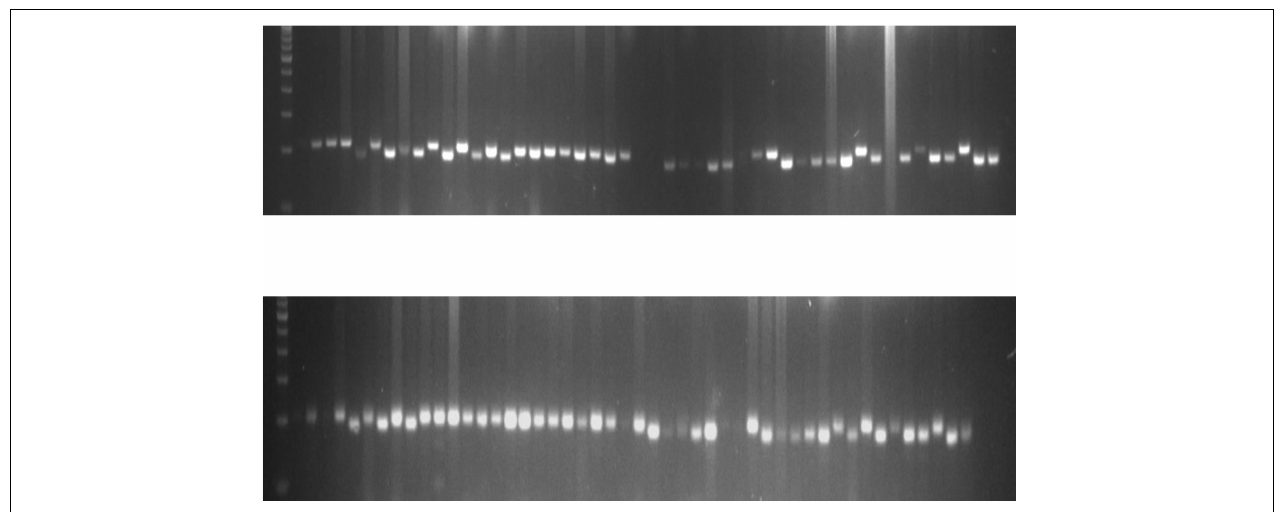
FIGURE 9 | Gel picture showing the allelic variation of SSR locus sesamum EST marker (SEM) 53 and SEM 4 across sesame genotypes.